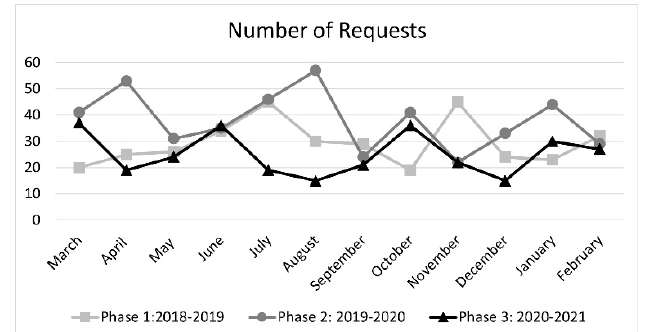
Figure 1 Number of Requests within 3 Phases